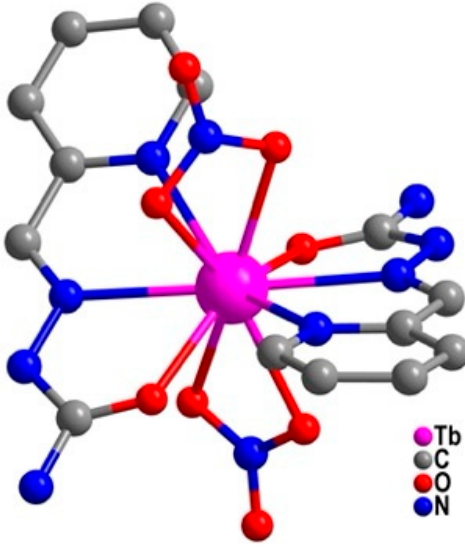
Figure 19. Molecular structure of complex 35 . The figure is reproduced from Reference [56] with permission from the Elsevier Ltd.